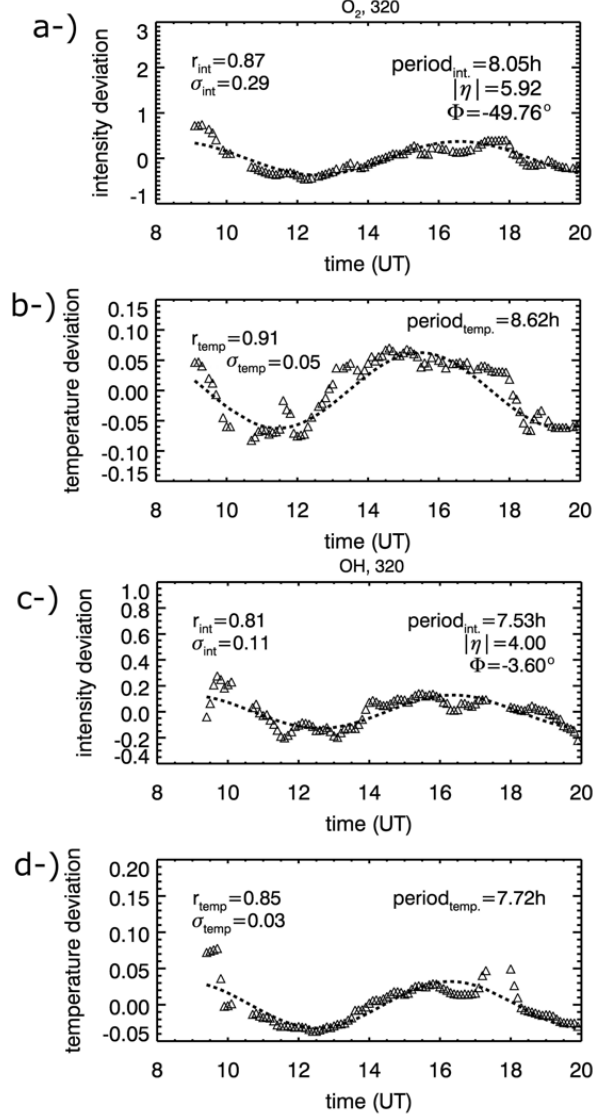
Fig. 2. As same as Fig. 1, but for 14 December 2004. Fig. 3. As same as Fig. 1, but for 15 November